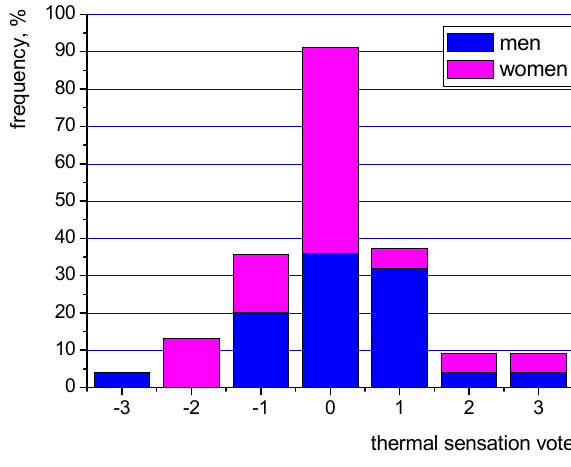
Figure 16. Thermal sensation votes in the lecture theater.